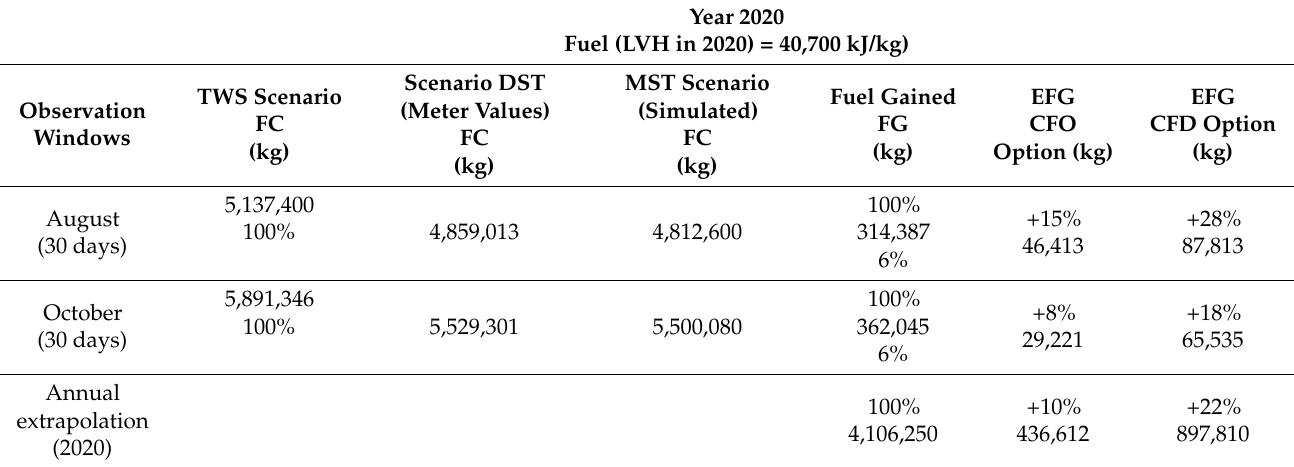
Table 8 summarizes the results obtained in 2020. Table 8. Comparative analysis of potential fuel gains based on design options 1 and 2 for the year 2020.